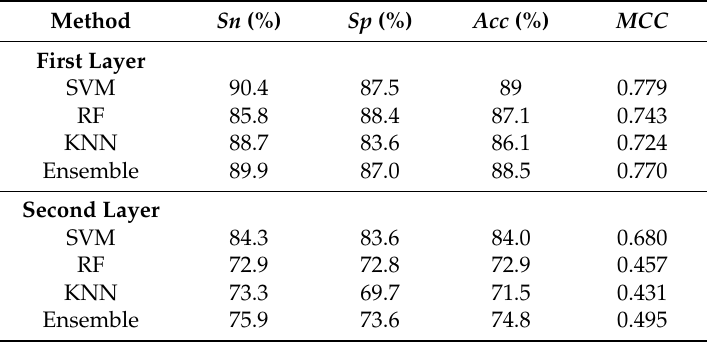
Table 5. The performances of different classifiers on the jackknife test.